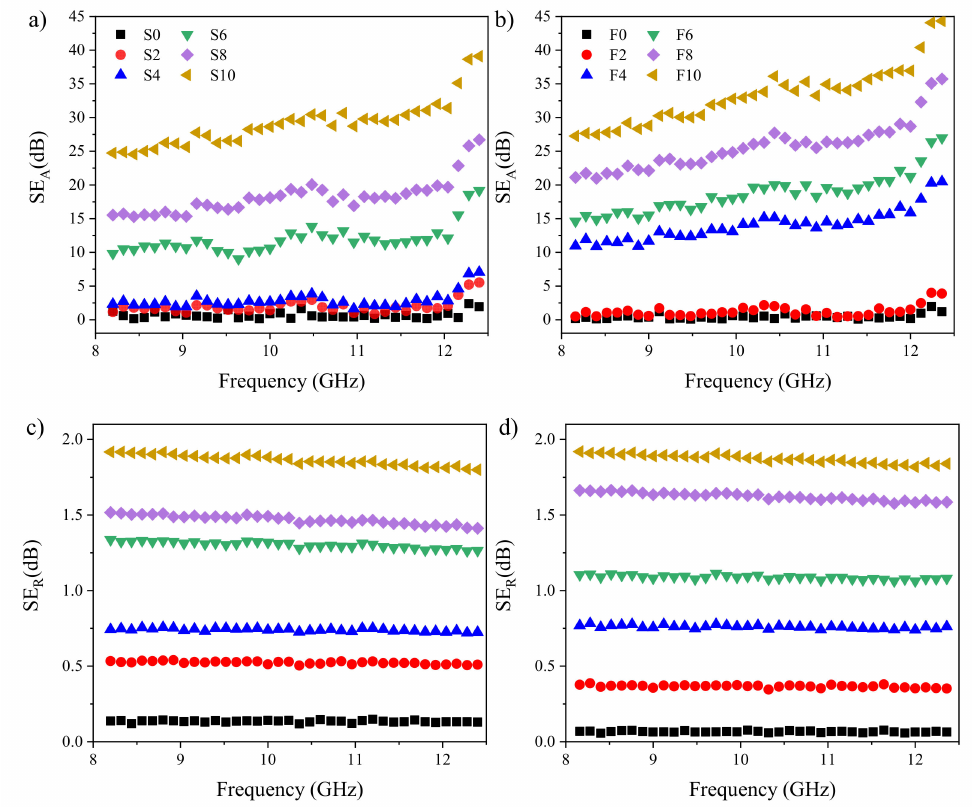
Figure 5. SE A ( a , b ) and SE R ( c , d ) of solid (left) and foam (right) samples in the X-band frequencies.